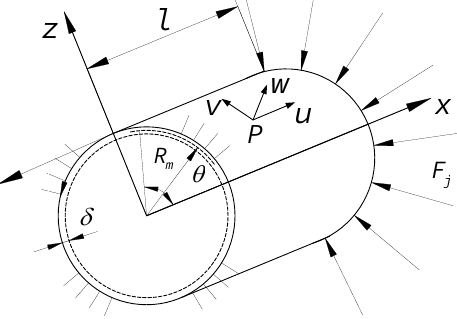
Figure 3. Dynamic model of the UUV body structure.